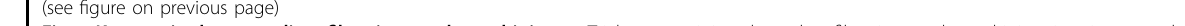
Ketanserin and qPCR analysis shows decreased expression of ASM; n = 5, scale bar 100 μ m; n = 3 per group for qPCR. b The accumulation and spatial pattern of macrophages do not change in the livers of mice treated with or without Ketanserin; n = 5, scale bar 50 μ m. c BMDM treated with and without ketanserin and then exposed to fl uorescently labeled zymosan particles show no difference in the number of macrophages, which engulf zymosan particles; scale bar 200 μ m. d BMDM treated with Ketanserin engulfed fewer zymosan particles compared to control. e qPCR analysis of relative mRNA expression of M1 and M2 associated genes of BMDM from healthy mice treated with vehicle or Ketanserin. Note that expression level in treated group (Ket) divided to control for each biological replicate. f Co-culture of mature BMDM, pretreated with vehicle or Ketanserin, with mature BMD-MSCs shows downregulation of Col1a1 expression in BMD-MSCs; scale bar 50 μ m. * P < 0.05, ** P < 0.01, *** P <